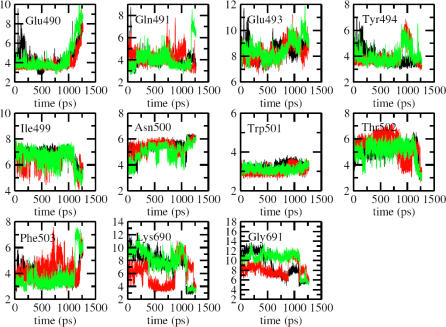
The Minimal Distances (in Å) in the TMD Simulations between Trp501 with Sidechains and Backbone Carbonyl Group Atoms That May Contribute to the ATP-Induced (De-)Quenching of Trp501 FluorescenceThese groups include Glu490, Gln491, Glu493, Tyr494, Ile499 (backbone carbonyl), Asn500, Trp501 (backbone carbonyl), Thr502 (backbone carbonyl), Phe503 (backbone carbonyl), Lys690 (including backbone carbonyl), and Gly691 (backbone carbonyl) as suggested by Málnási-Csizmadia et al. [40]. The different colors represent three TMD simulations.